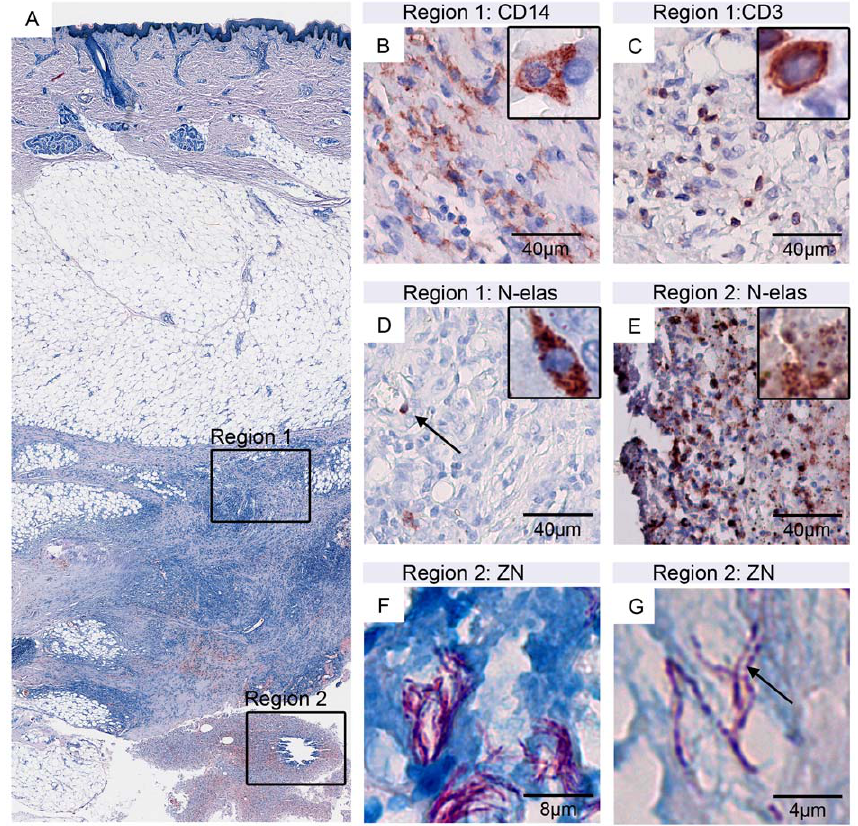
Figure 2. Histopathological presentation of secondary lesions. Histological sections (nodule 2 of patient 2) were stained either with Ziehl- Neelsen (counterstain methylenblue; A, F, G) or with antibodies against cell surface or cytoplasmic markers (counterstain haematoxylin; B–E). A: Overview over excised tissue specimen revealing typical BU pathology features like fat cell ghosts, necrosis, epidermal hyperplasia and AFB (region 2) as well as a strong mixed infiltration typically observed in successfully treated BU lesions (region 1). B: CD14 staining of macrophages/monocytes; C: CD3 staining of T-cells; D: Elastase staining of neutrophils. In the necrotic region 2 large numbers of elastase-positive neutrophilic debris (E) and small clumps of AFB (F) with a beaded appearance (G) were observed.